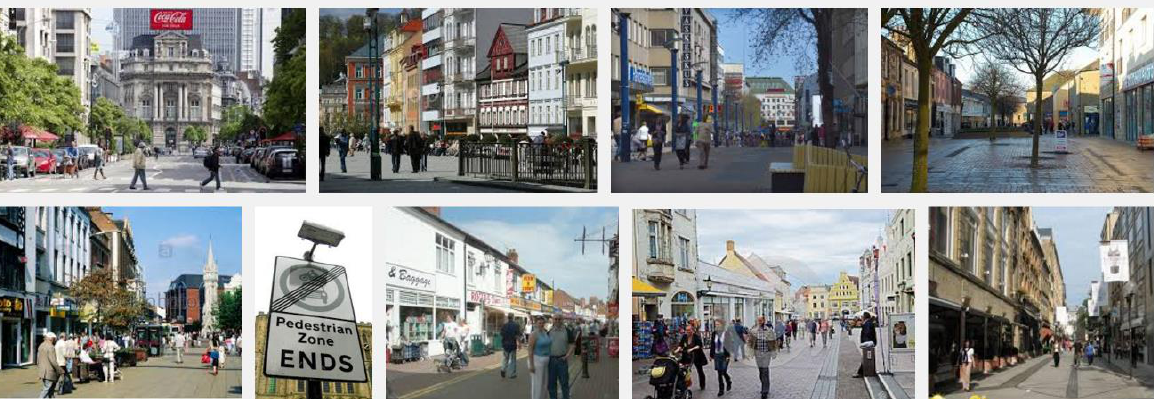
Figure 7. Examples for strategy Pedestrian precincts (PP)